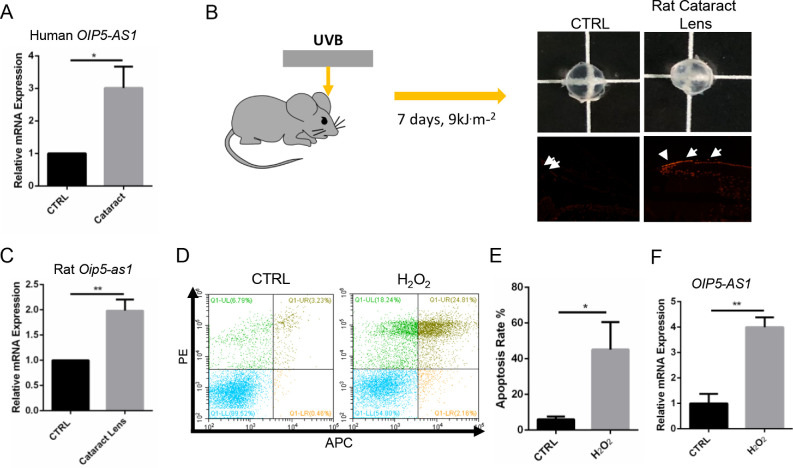
OIP5-AS1 expression was upregulated in clinical lens samples and cataract models. (A) RT-qPCR of OIP5-AS1 expression in lens capsules. (B) Rats underwent a total of 9 kJ.m2 UVB irradiation for 7 days and were then sacrificed. Their lenses were isolated, photographed, and stained using TUNEL dye for observation. The white arrows indicate the TUNEL-positive cells. (C) Oip5-as1 was upregulated in the lens of rats with cataract as shown by RT-qPCR. (D–E) H2O2 (200 µM) was chosen for the oxidative stress cell model. (F) OIP5-AS1 increased in the oxidative stress cell model, as shown by RT-qPCR. *P < 0.05, **P < 0.01.